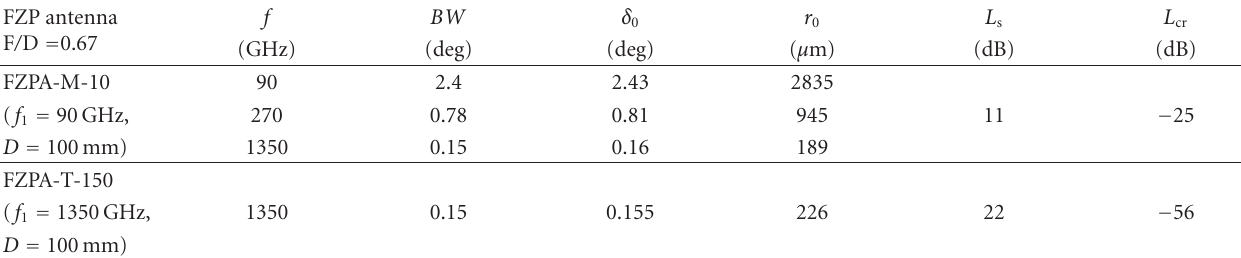
Table 3: Radiation pattern parameters of FZP lens antennas: microwave (M) and terahertz (T) designs. FZP antenna